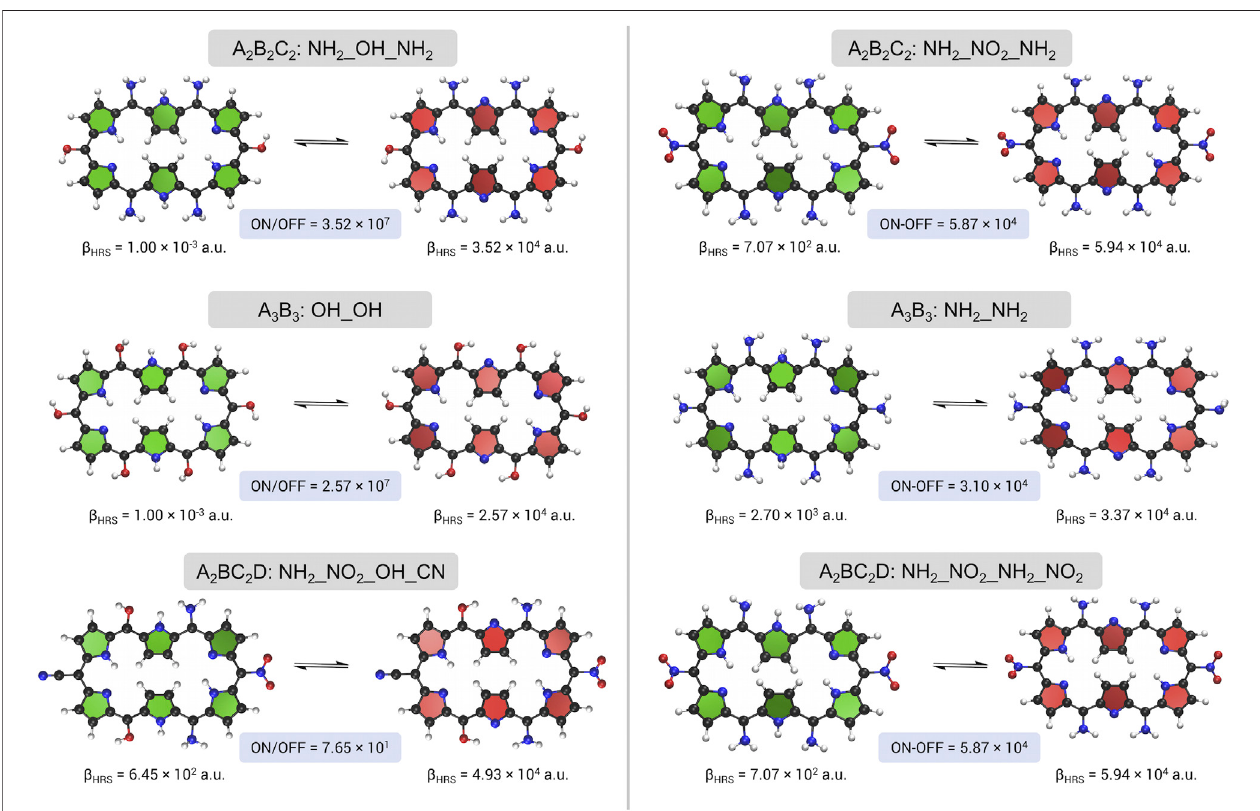
FIGURE 6 | A schematic overview of the redox switches with the highest NLO contrast, β HRS ratio on the left and β HRS difference on the right, upon meso - substitution for the three substitution patterns.